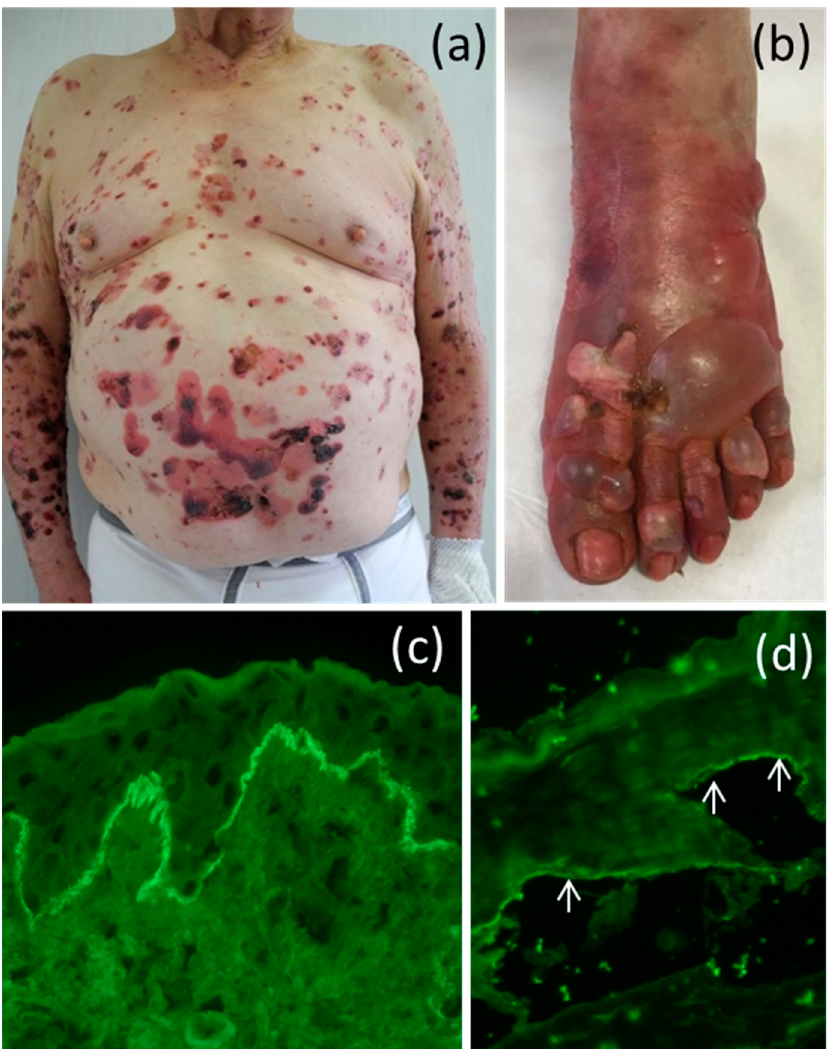
Figure 1. Clinical and immunological features of patients affected by gliptin-induced bullous pemphigoid ( a , b ) clinical presentation of two gliptin-associated bullous pemphigoid (BP) patients. Large tense blisters on erythematous plaques on trunk, arms, and foot are present. ( c ) Linear deposits of IgG at the dermal-epidermal junction by direct immunofluorescence microscopy. ( d ) IgG labeling of epidermal side (pointed by arrows) on human salt-split skin by indirect immunofluorescence microscopy.